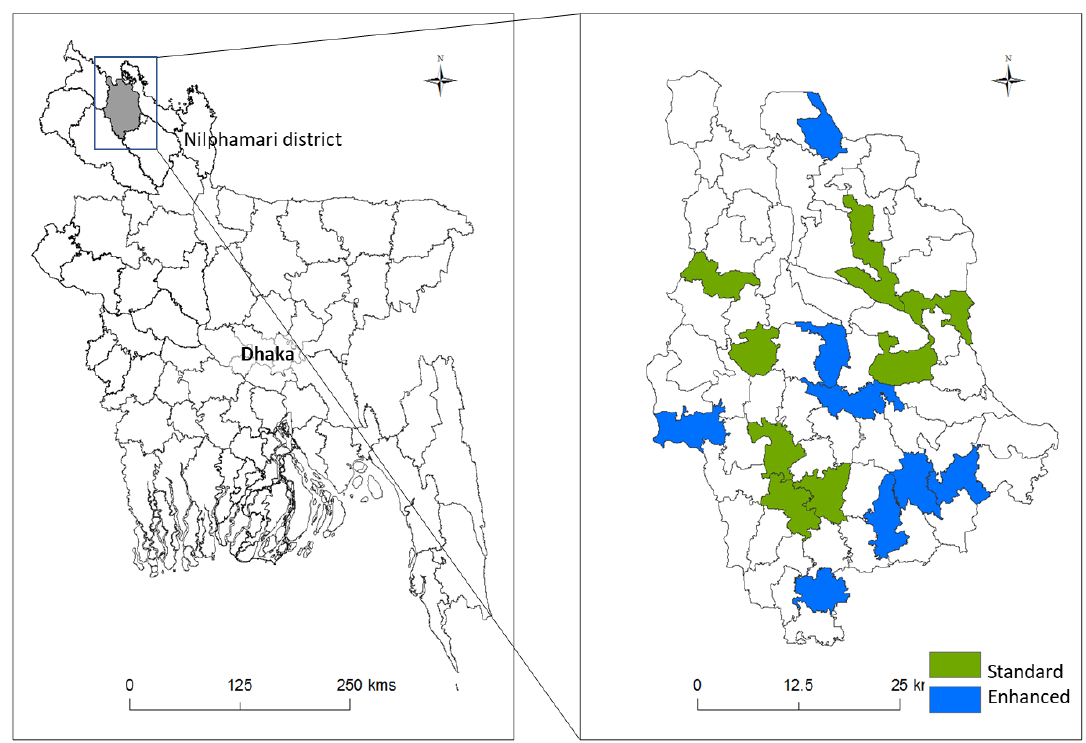
Figure 1. Map of all included community clinics in Nilphamari District, Bangladesh.